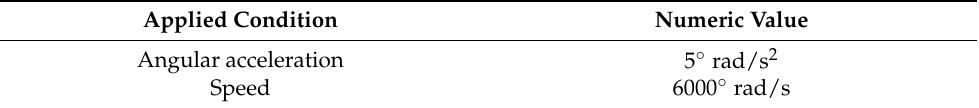
Table 2. Optimised applied flywheel conditions.